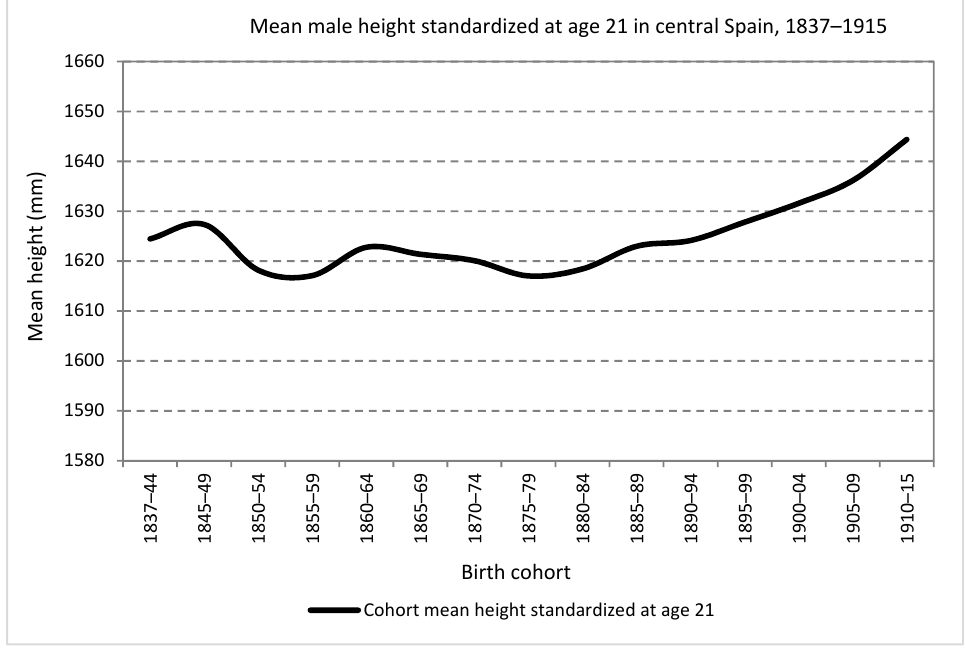
Figure 2. Mean male height at age 21 in central Spain, birth cohorts 1837–1915 (Source: calculated with data from the Expedientes ).